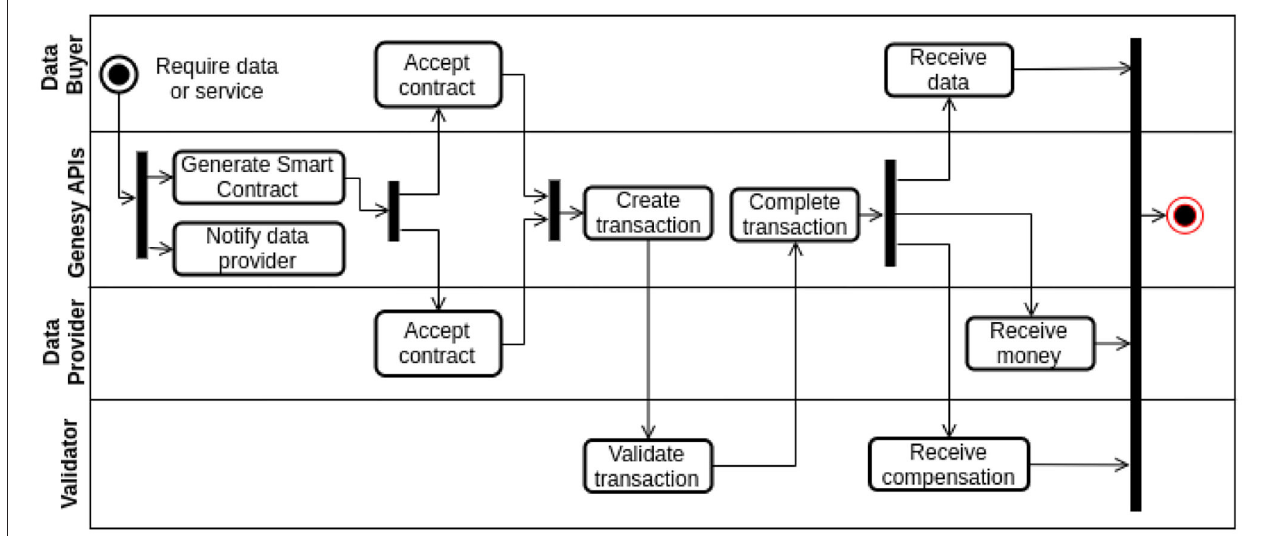
FIGURE 6 | Activity Diagram in UML notation depicting a general transaction in Genesy. A data provider is a company or the data owner who had previously sequenced and shared her DNA and who has interesting traits that the data buyer (i.e., the data requester) wants to analyze further. A data buyer is a customer wanting to have her DNA sequenced and then securely and privately stored. The same schema also applies when both data buyer and data provider are companies wanting to exchange data or services, for example when a pharma company (data buyer) requests data or a service to a DNA sequencing provider (data provider), to provide, say, different solutions to their